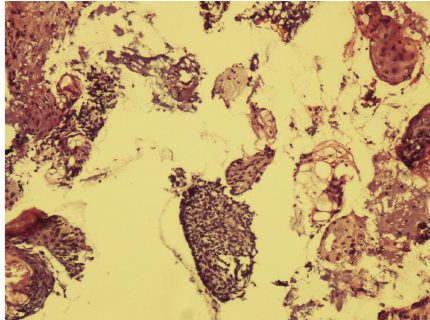
Figure 3: Shave sample of induced defect after CO 2 laser indicates presence of malignant cells (H&E stain × 100).